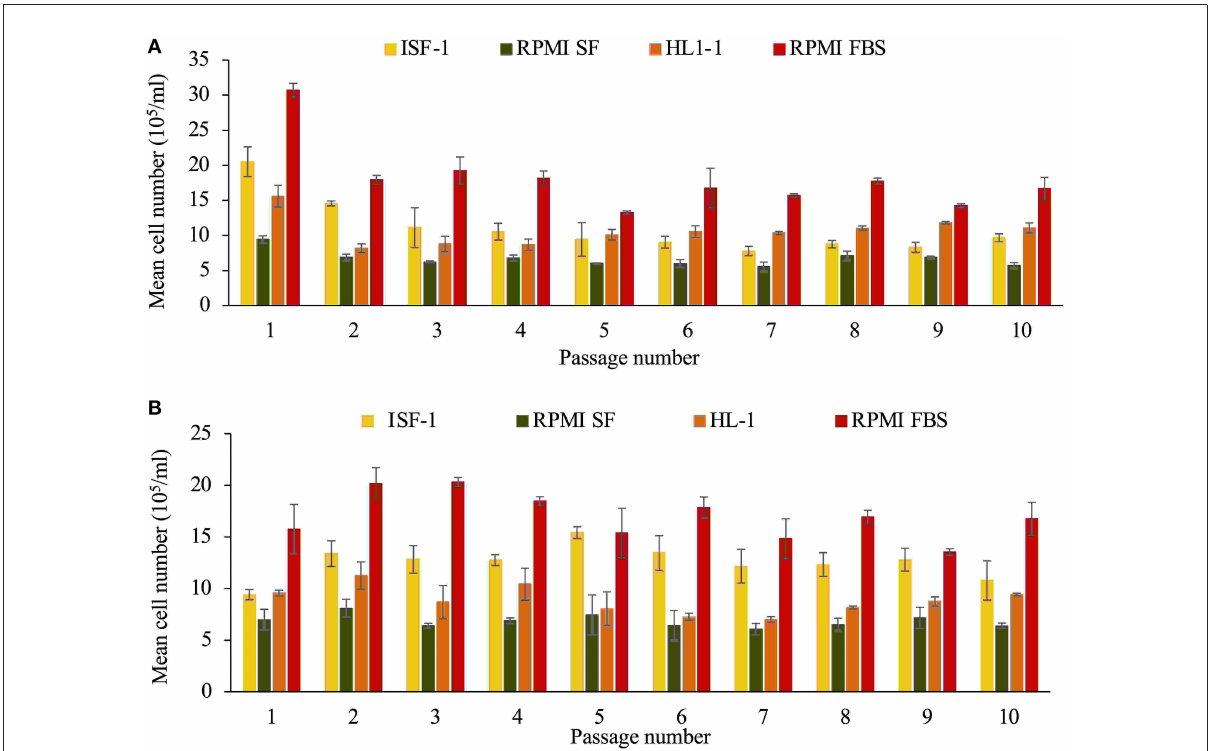
FIGURE1 Growth of the T. annulata Beja (A) and Hessiene (B) cell lines as measured over ten passages (starting from passage 22 for Beja and passage 23 for Hessiene) in different serum-free media and RMPI supplemented with 10% fetal bovine serum (RPMI-FBS). Bars indicate standard deviation from the mean cell number of each culture replicate.